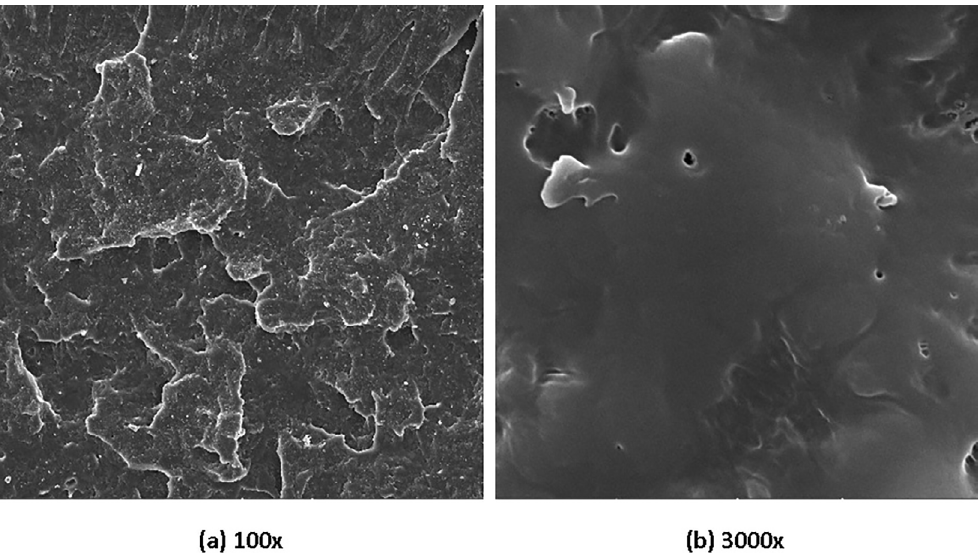
Figure 7. SEM images of neat PCL in different magnifications, on the Figure 7a with magnification of 100x and the Figure 7b with magnification of 3000x.